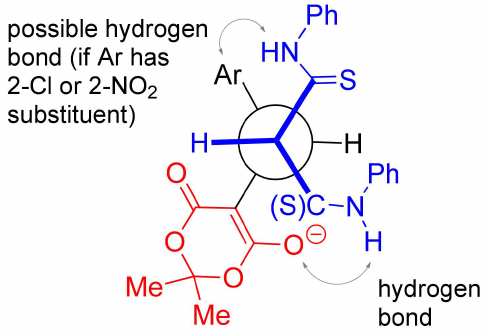
Figure 1. Hydrogen bonding in Michael adducts 15